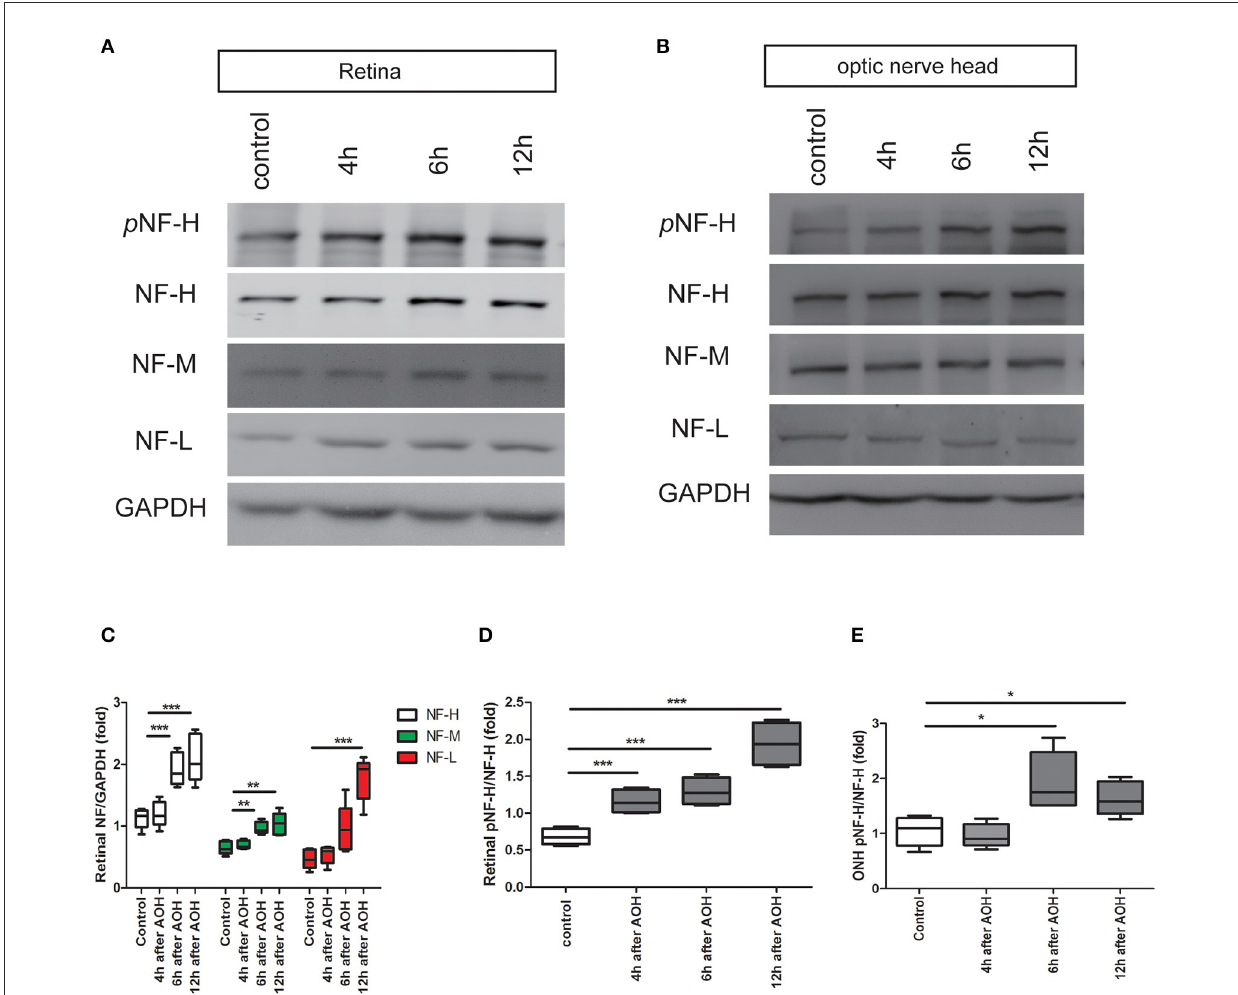
FIGURE3 Early elevation of pNF-H expression observed in the retina and ONH following induction of AOH. An obvious elevation of the neurofilament was also observed in the retina. (A) Representative blots of NF-H, M, L, and pNF-H from AOH and the control retinas at 4, 6, and 12h are shown. In the retina, the bands of the neurofilament three subunits were more visible at 6 and 12h, while the band of pNF-H was more visible as early as 4h. pNF-H, NF-H was recognized at 200 kDa, NF-M was visible at 160 kDa, and NF-L was at 70 kDa. GAPDH was used as an internal control. (B) The expression of neurofilament subunits and pNF-H in the ONH was traced at 4, 6, and 12h after AOH, but western blotting of the ONH showed that NF-H, NF-M, and NF-L were unchanged, while the pNF-H band increased significantly at 6h. (C) Densitometry measurements of three neurofilament subunits in the retina (normalized for GAPDH and expressed relative to the control) are provided in the box-and-whisker plots, n = 5 mice for each group, ** P < 0.01, *** P < 0.001. (D, E) Quantification of pNF-H expression from the retina at 4h and ONH at 6h is shown as box-and-whisker plots, respectively. n = 5 mice for each group, * P < 0.05, *** P <